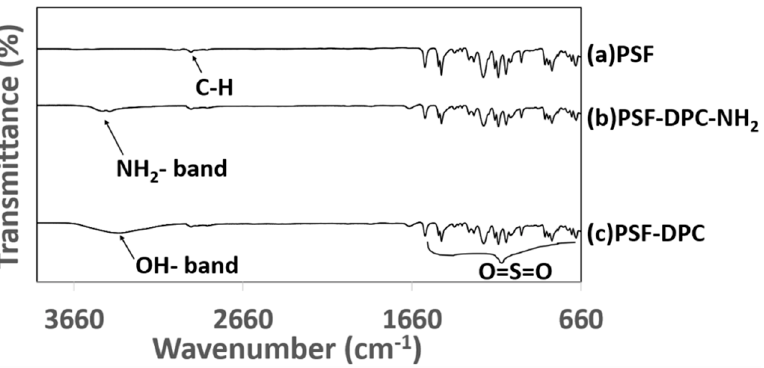
Figure 6. IR-spectra of membrane samples ( a ) polysulfone (PSF), ( b ) PSF-DPC-NH 2 , and ( c ) PSF-DPC.